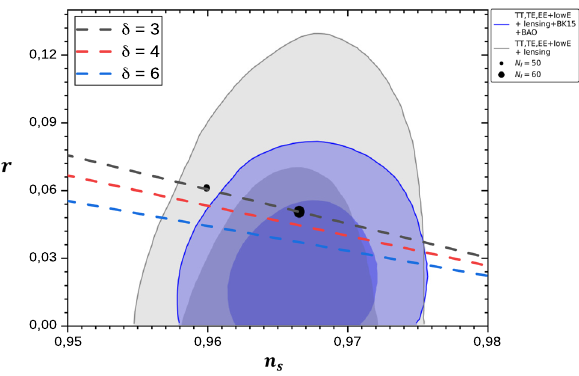
Fig. 1 r as a function of n s for a chaotic potential in modified telepar- allel gravity. Inner and outer shaded regions are 1 σ and 2 σ constraints incombination withCMBlensing reconstruction andBAO from Planck data, respectively. We choose three different values of δ , the black line for δ = 3 , the red line represents δ = 4 and the blue line for δ = 6. The dots correspond to 50 and 60 inflationary e-folds for the case of δ = 3,